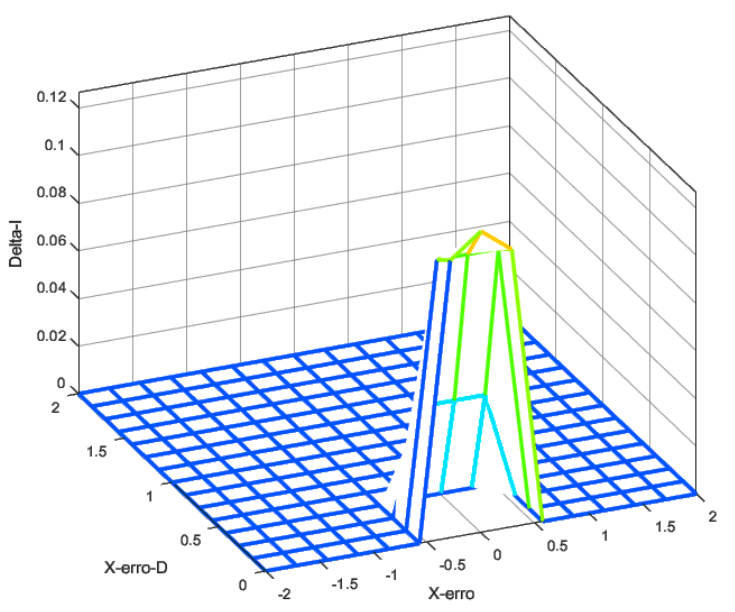
Figure 10. Fuzzy surface for integral